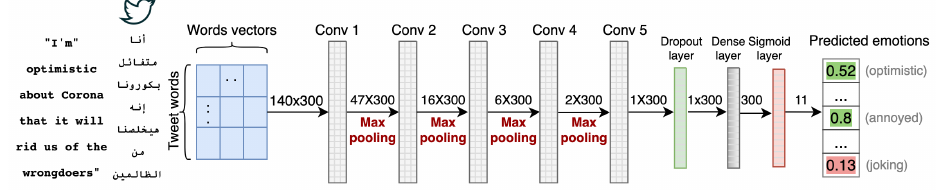
Figure 3. The architecture of the proposed CNN model for sentiment analysis.